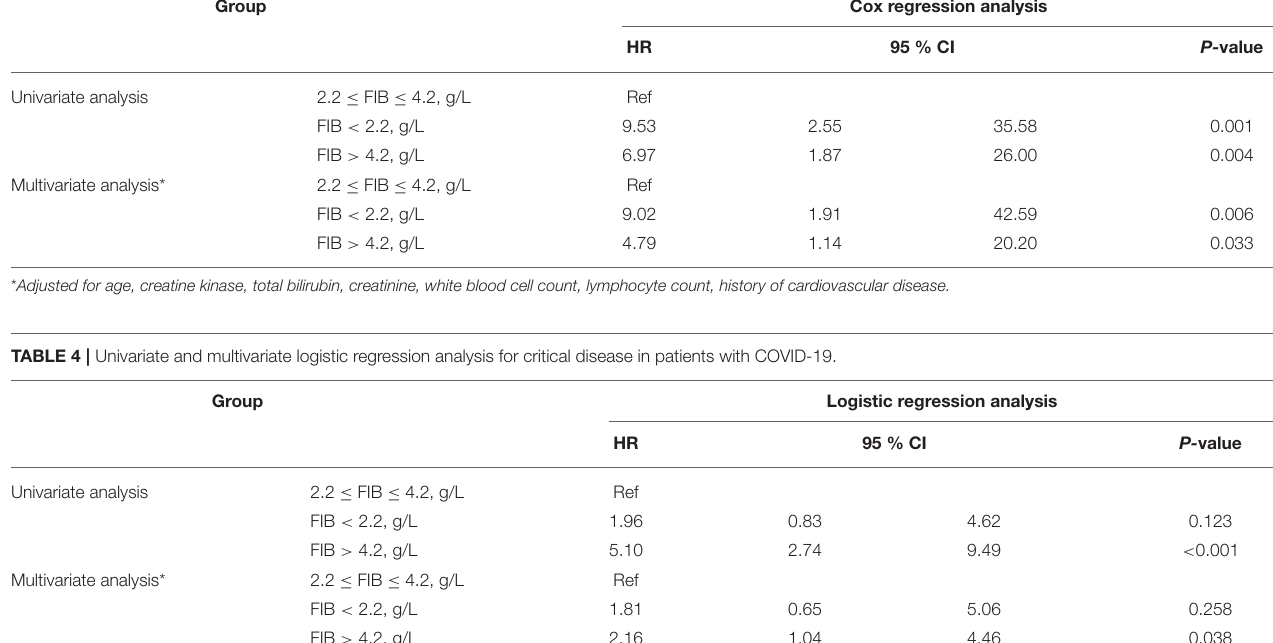
TABLE 3 | Univariate and multivariate Cox regression analyses for mortality in patients with COVID-19. Group Cox regression analysis HR 95 % CI P- value Univariate analysis